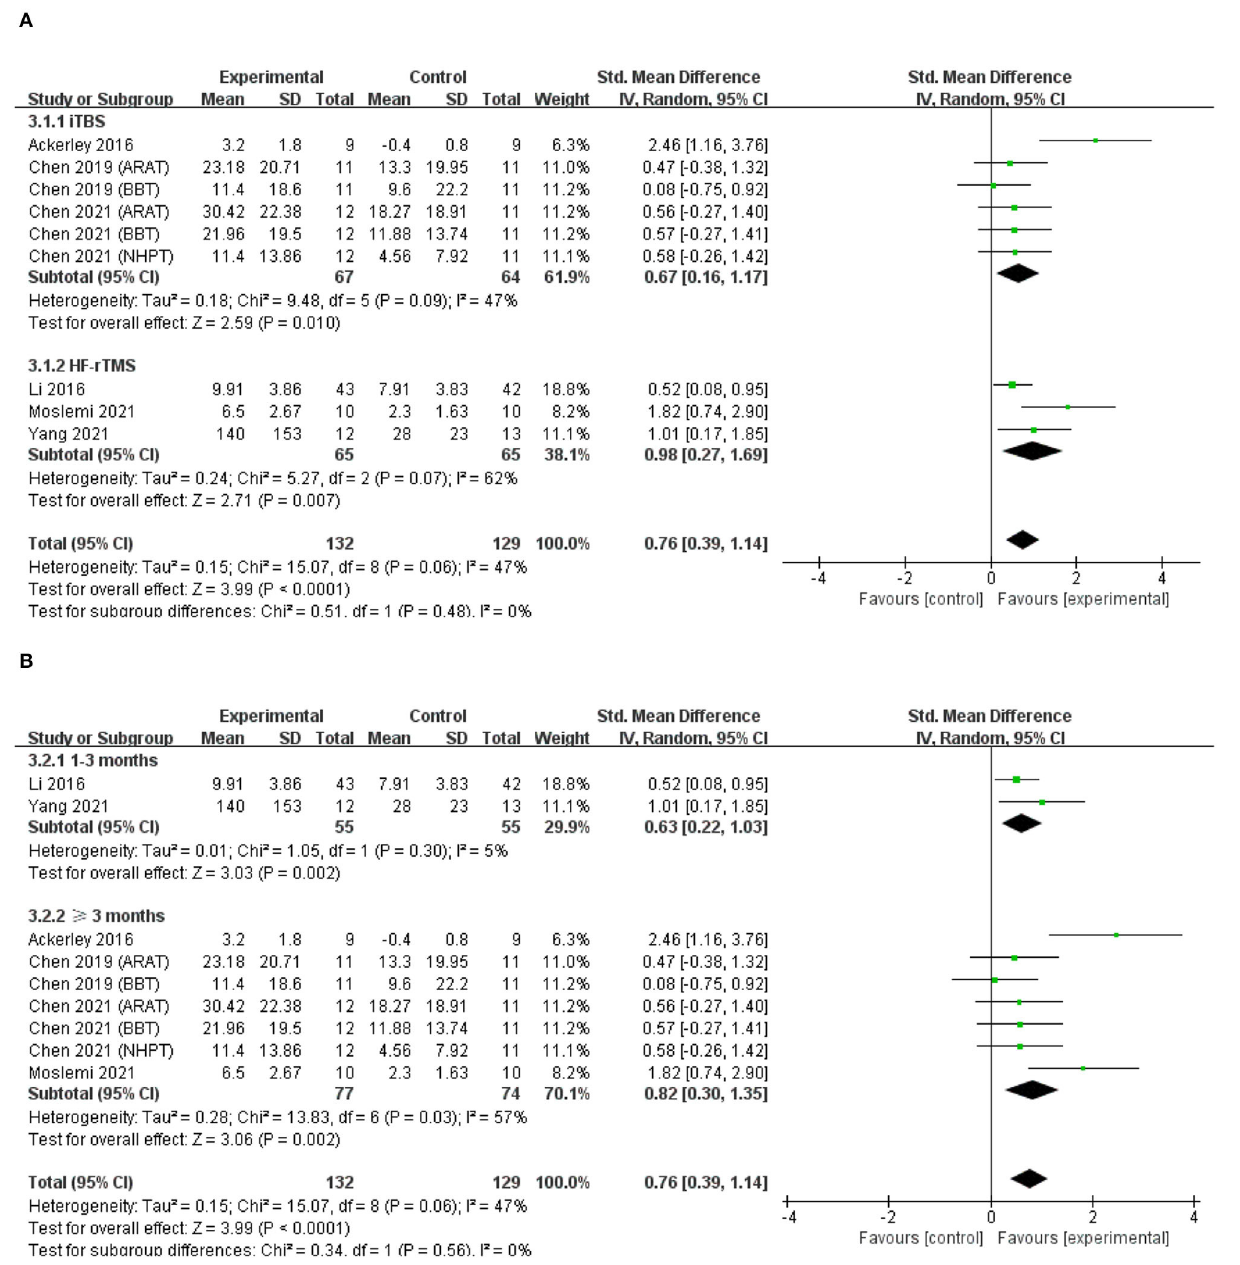
and hand dexterity, similar to the previous studies (26,